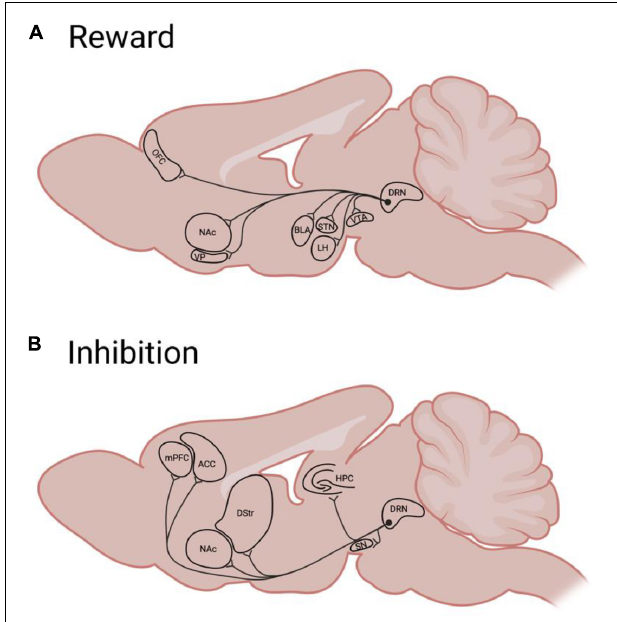
FIGURE 2 | A simplified schematic of rodent Dorsal Raphé serotonergic efferents to brain regions implicated in reward (A) or behavioral inhibition (B) . ACC, anterior cingulate cortex; BLA, basolateral amygdala; DRN, dorsal raphé nucleus; DS, dorsal striatum; HPC, hippocampus; LH, lateral hypothalamus; mPFC, medial prefrontal cortex; NAc, nucleus accumbens; OFC, orbitofrontal cortex; STN, subthalamic nucleus; SN, substantia Nigra; VP, ventral pallidum; VTA, ventral tegmental